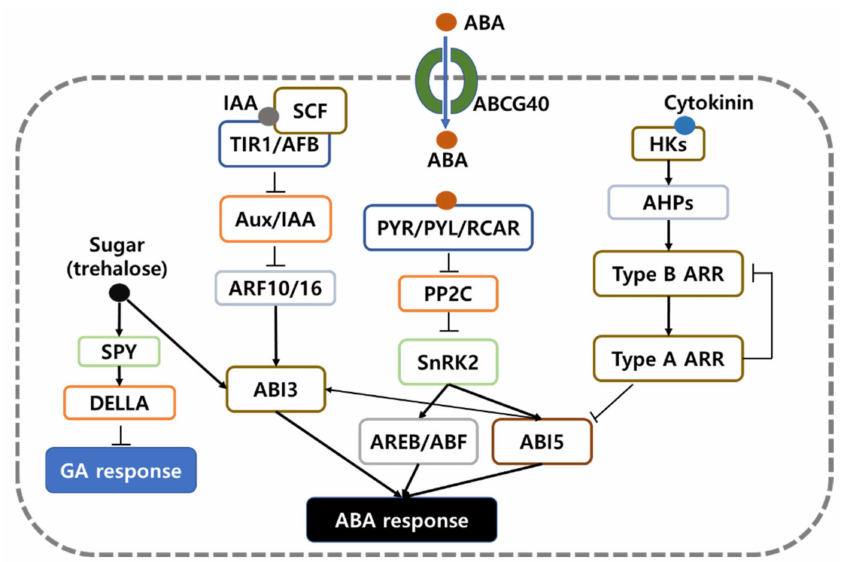
Figure 7. Proposed schematic diagram of the DEGs identified by RNA-seq transcriptome analysis in this study.